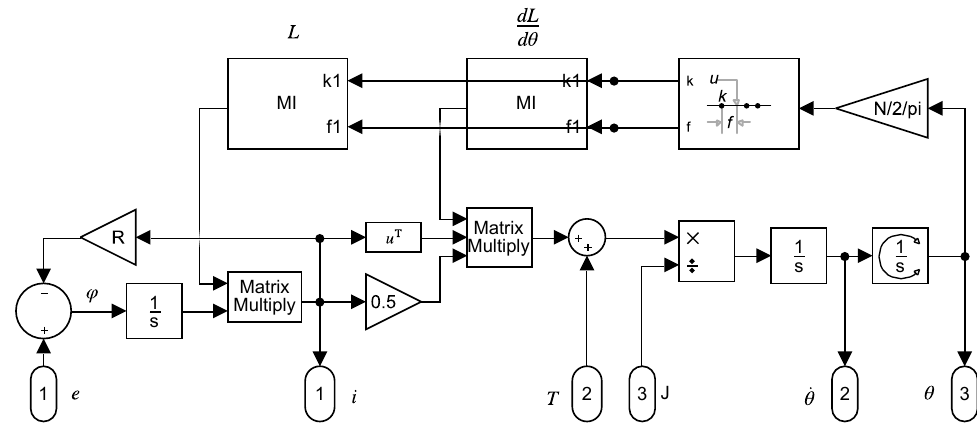
Figure 2. Analytical model that implements (2) in